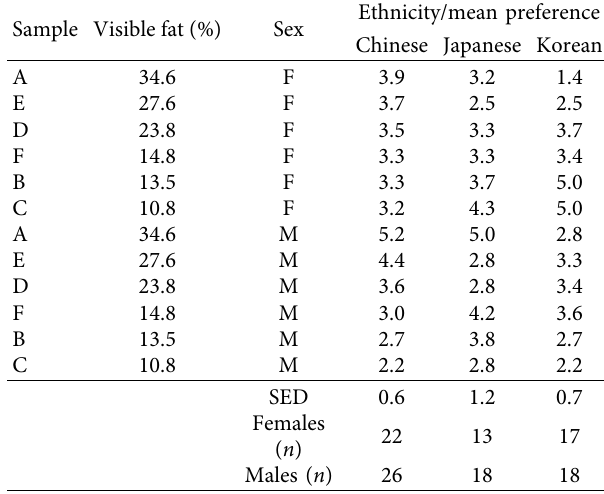
SED � standard error of difference between means within each ethnic group.